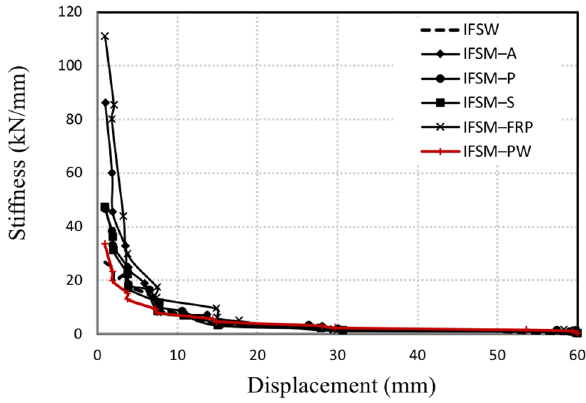
Figure 9. Secant stiffness of specimens.